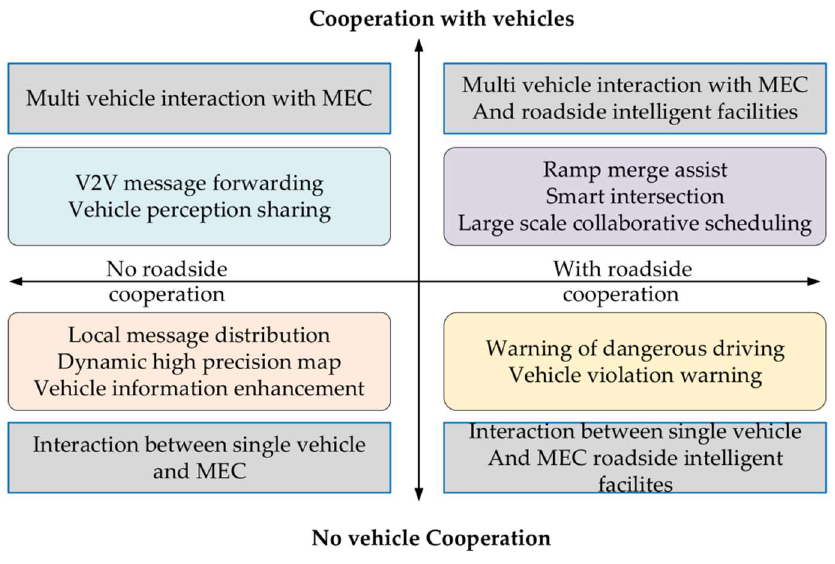
Figure 8. Application scenarios for 5G and C-V2X.